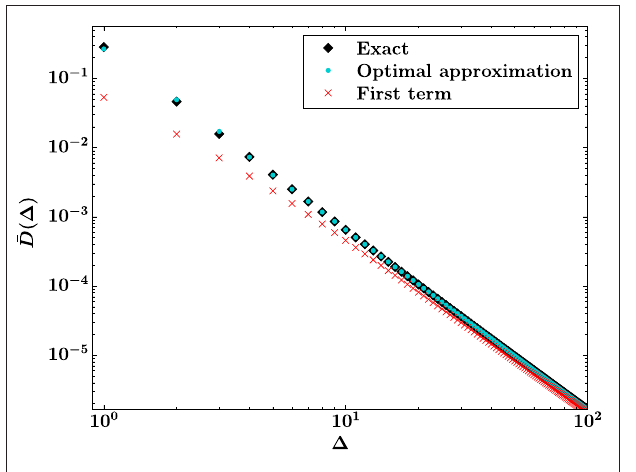
FIGURE 4 | Optimal approximation from Equation (44) with 13 available terms (turquoise) and exact result (black) for the burst distribution. The first term of the asymptotic series (red), which is Equation (4), is shown for comparison. The threshold distribution is a Weibull distribution with k 1 and t 0 0. = =